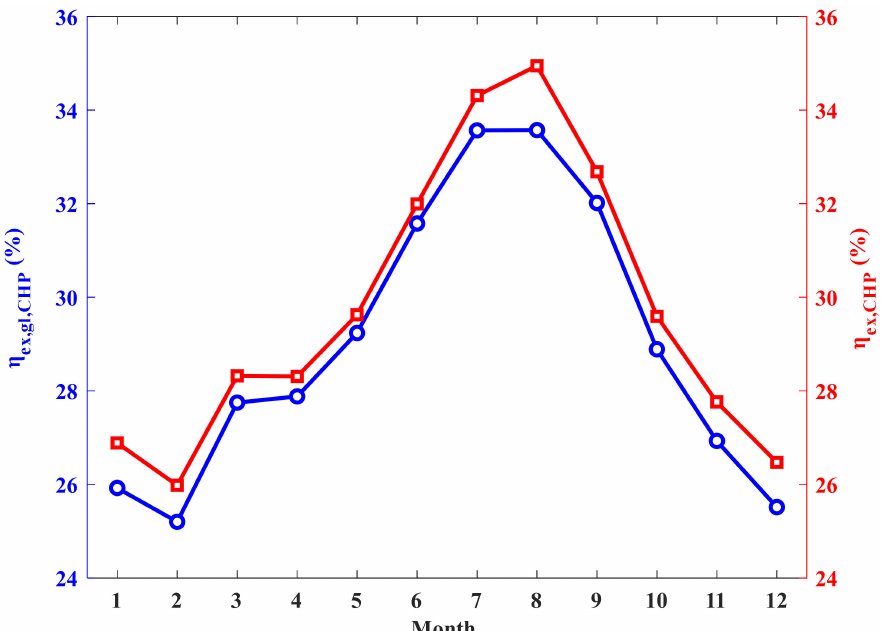
Figure 17. Monthly global exergy efficiency and exergy efficiency of the CHP system.